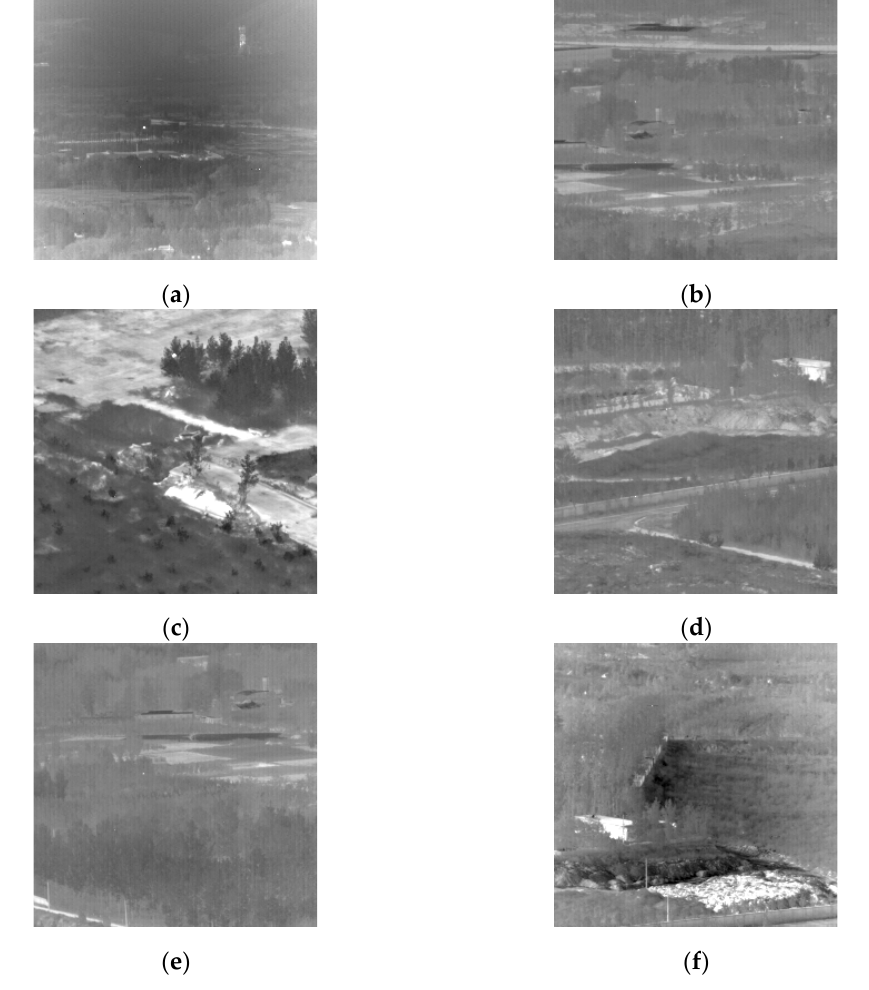
Figure 6. These six images are from the dataset used in this experiment, and the targets are pointlike and not the brightest area in the image, with a complex background. Not only images ( a , d , e ) contain one bright spot, but also it is difficult to identify which bright spot is the real target by directly observing a single frame of the image, making the detection task more challenging. The background of images ( b , c , f ) is not as complex but the target is also small and weak.